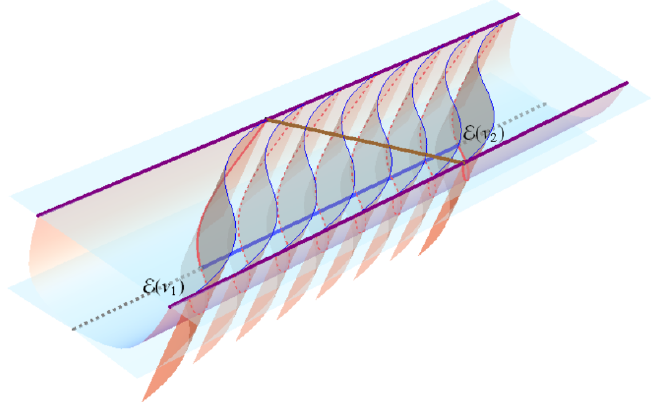
Figure 9 . The entanglement wedge is shown as a slicing of the modular planes. We denote the thick blue line in the bulk as E reg . We only depicted the modular planes that go through A reg . The modular planes P ( v 1 ) and P ( v 2 ) intersect with A and E on the points where they are cut